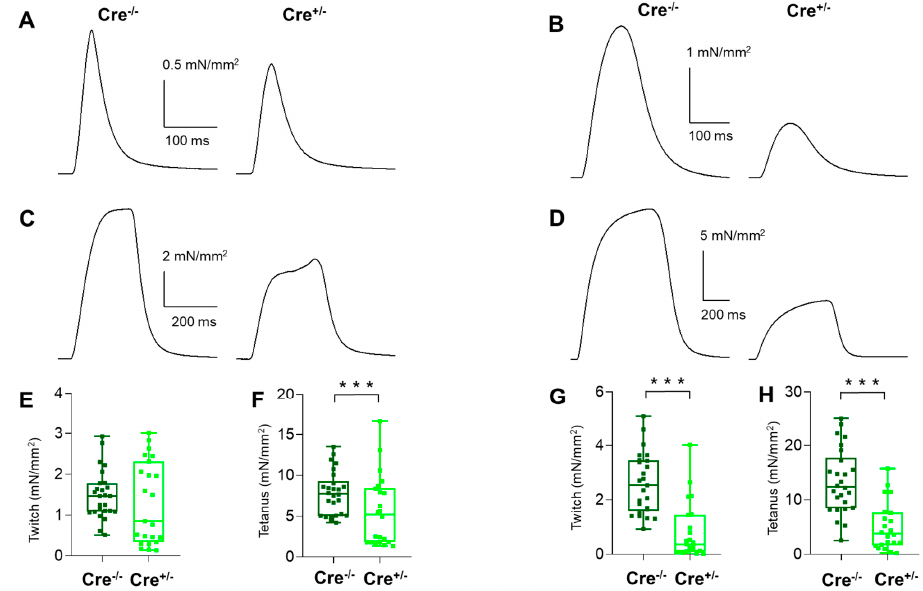
Figure 2. Altered isometric force in EDL and SOL muscle from Cre +/ − mice. Representative twitch ( A , B ) and tetanic force ( C , D ) transients in EDL ( A , C ) and in SOL ( B , D ). The force was normalized to the cross section of the muscle. Box plots show the individual data points for the peak twitch ( E , G ) and tetanic ( F , H ) force in EDL ( E , F ) and SOL ( G , H ) from Cre − / − ( N = 13 mice, n = 26/25 muscles) and Cre +/ − ( N = 14 mice, n = 22 muscles). *** p < 0.001.